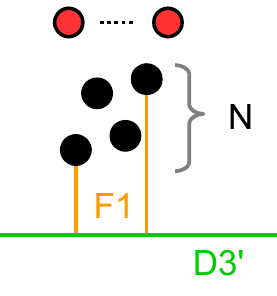
Figure 12 . Brane setup realising the insertion of the Casimir operator (cid:8) 2 = P the D3’ brane has two F1 strings attached. Only one pattern of strings is shown